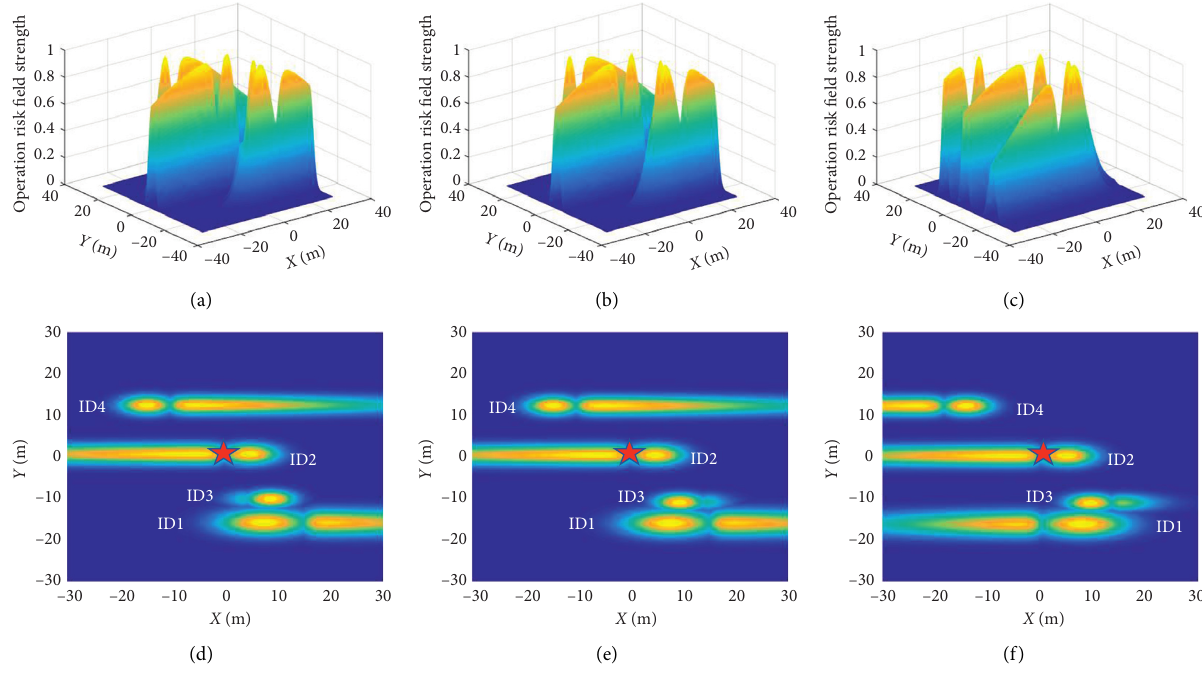
Figure 13: The changes of operational risk field prediction. (a) T � 1s. (b) T � 2s. (c) T � 3s. (d) T � 1 s. (e) T � 2 s. (f) T �